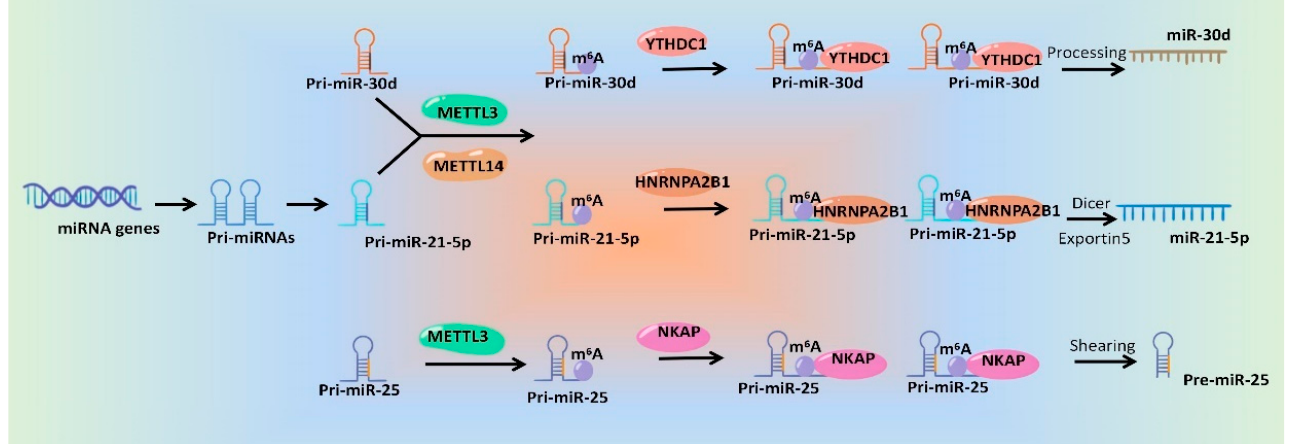
Figure 2. Schematic diagram of the mechanisms of m 6 A modification and its regulatory proteins regulating miRNA production. Table 1. m 6 A modification involves in regulation of miRNA expression.